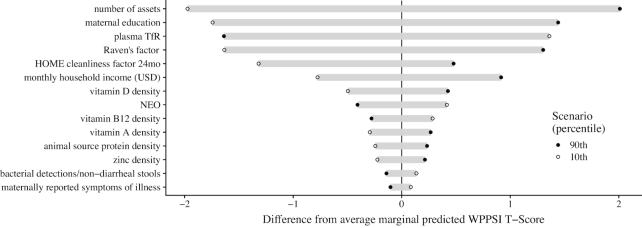
Difference in the predicted marginal difference in Wechsler Preschool and Primary Scale of Intelligence (WPPSI) scores at 5 y if individual variables are set at their respective 10th (open circle) or 90th (closed dot) observed percentile compared to the marginal mean. HOME, Home Observation for Measurement of the Environment; NEO, neopterin; TfR, transferrin receptor.